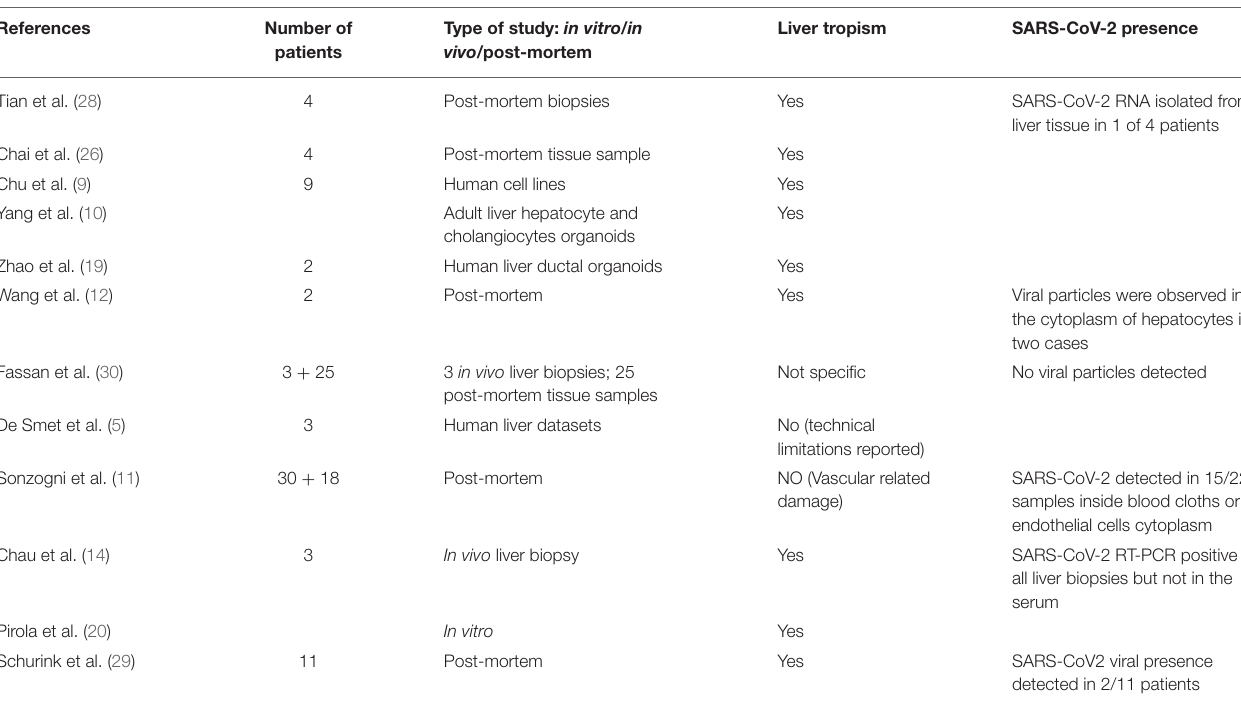
TABLE 1 | Studies on hepatotropism available in the